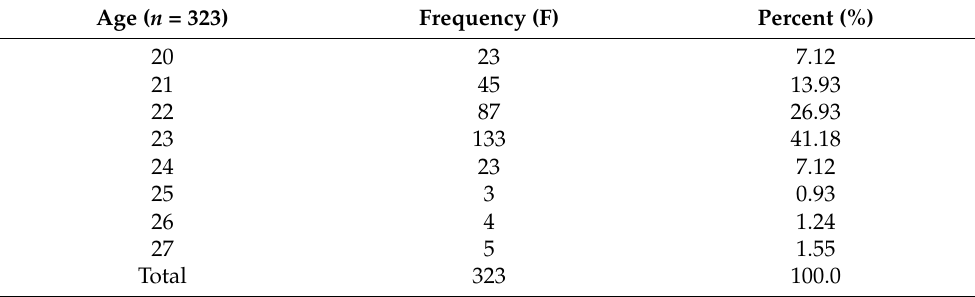
Table 4. Frequency and percentage of respondent age.